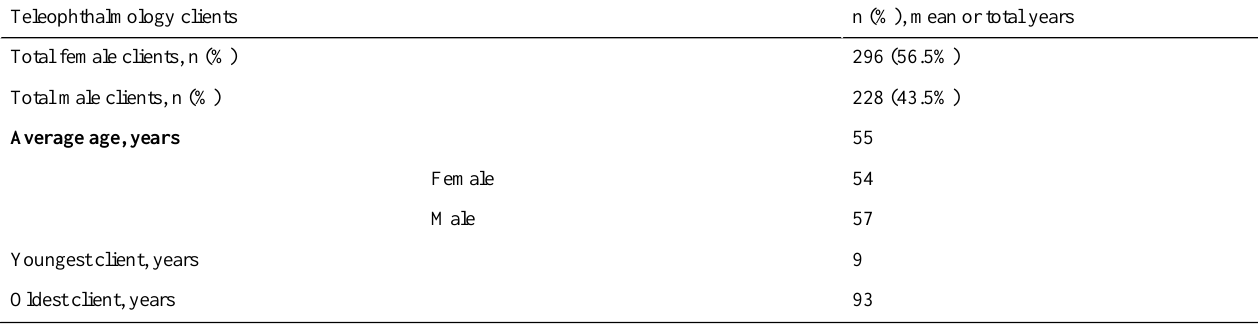
Table 1. Breakdown of teleopthalmology clients screened (n=524).